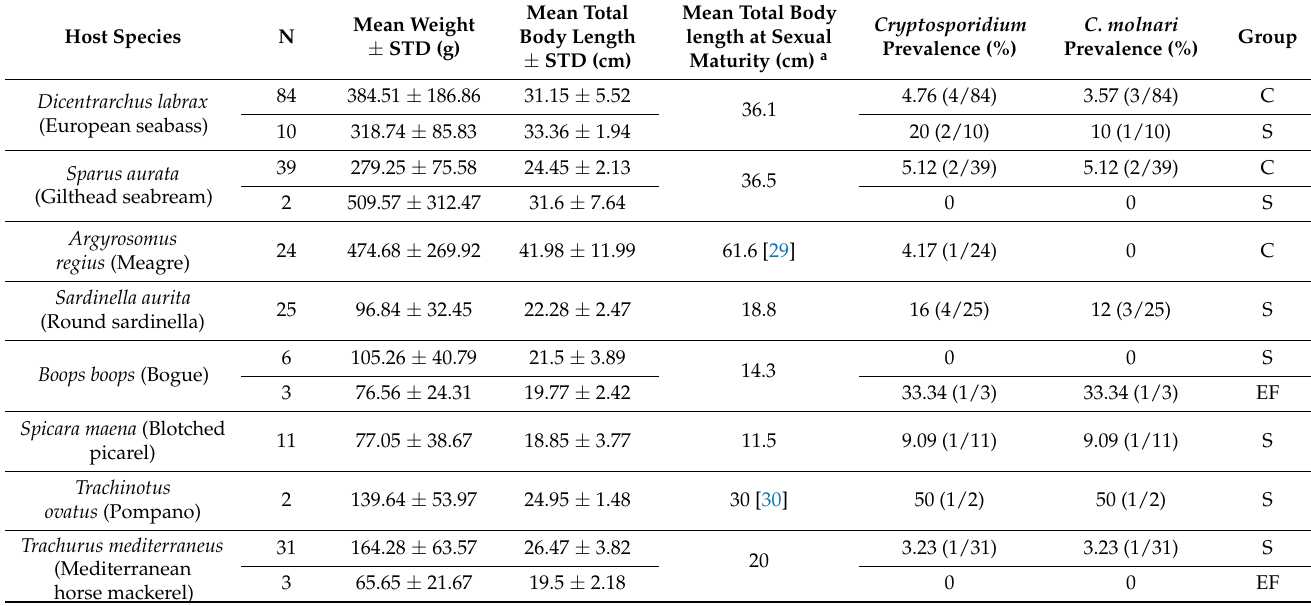
Table 2. Prevalence of Cryptosporidium spp. and C. molnari for each species in which positive individuals were detected. Study group, mean weight, total body length and reference total body length at sexual maturity are